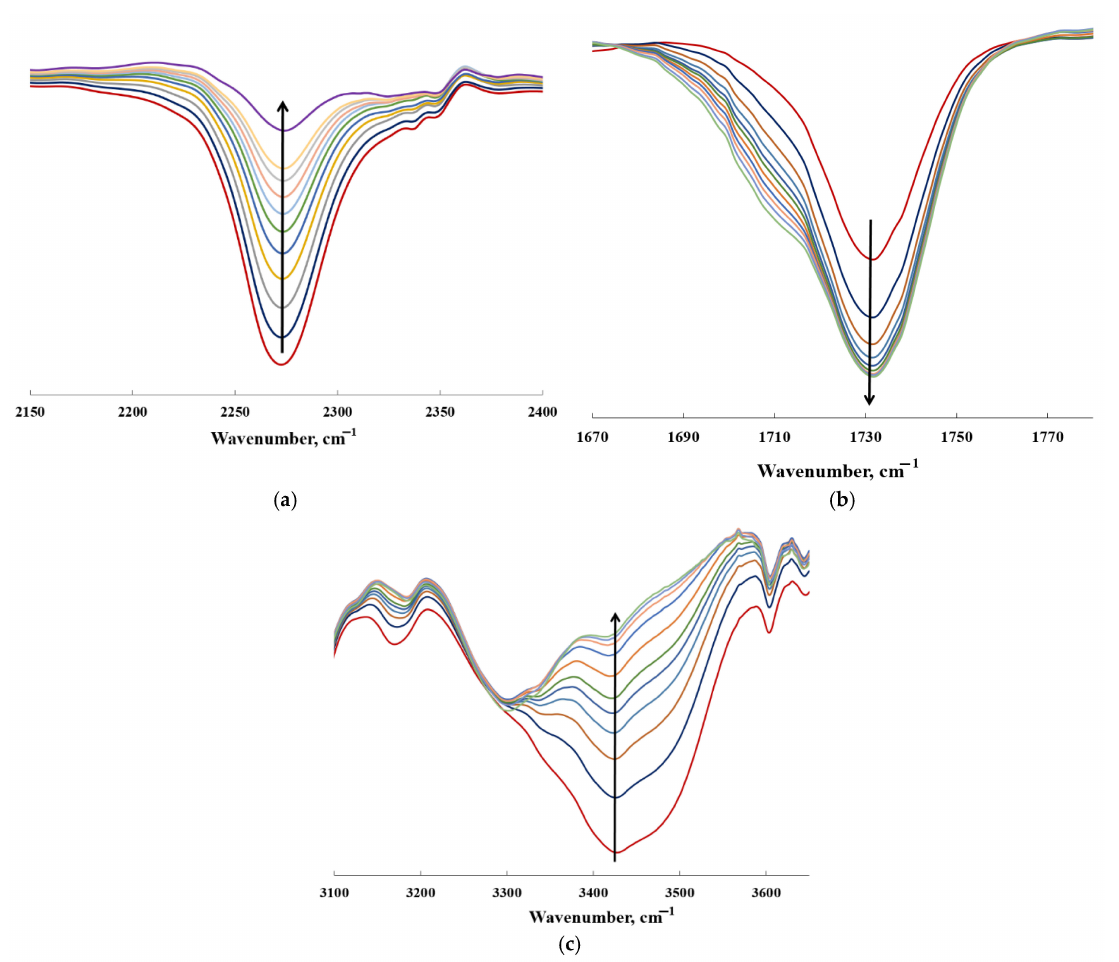
Figure 6. Temperature dependencies of dynamic viscosity ( η , mPa · s) of AEBA, AEBA-EM and PEG.